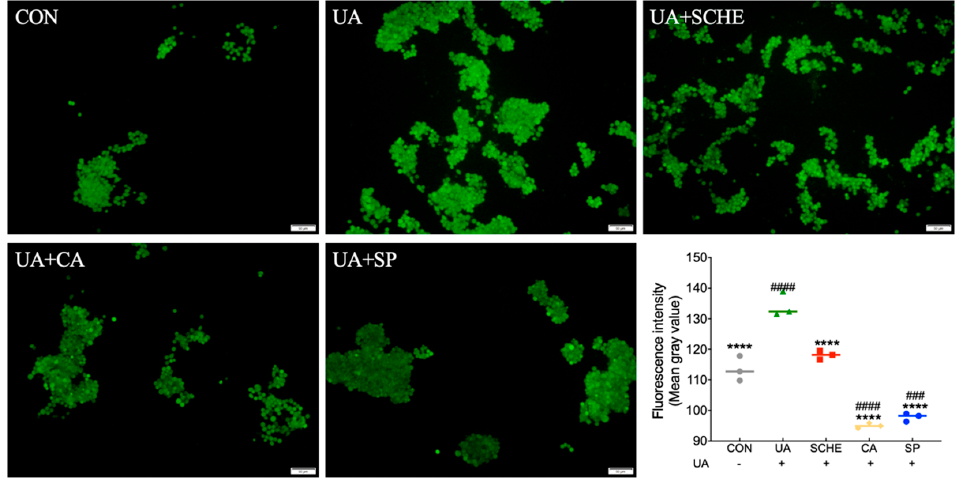
Figure 3. Single-channel fluorescence images on UA-induced 293T cells (200 × ). The cells were stimulated by 1 mM UA except for the control group. The gray scales were analyzed by Image J and represented as the mean and scatter of no less than three repeated experiments ( ### p < 0.001, #### p < 0.0001 vs. control group; **** p < 0.0001 vs. UA treatment).